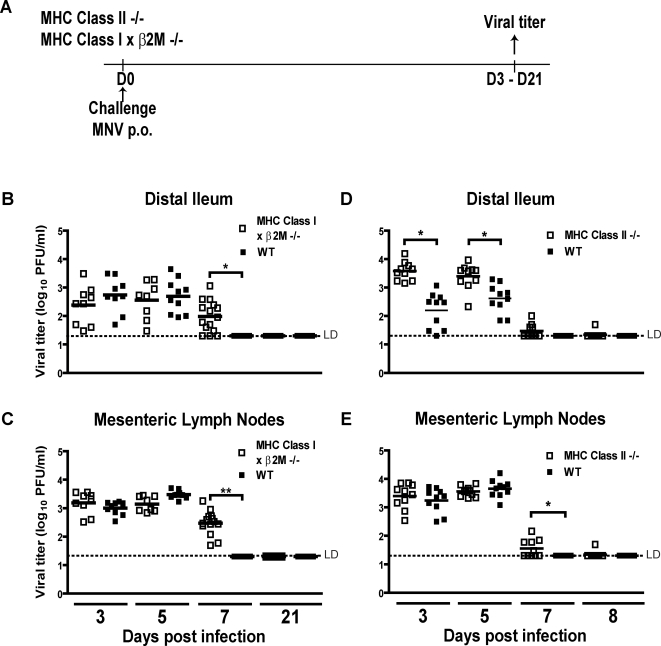
MHC Class II limits early MNV replication, and deficiency in MHC Class II or MHC Class I & β2M delays MNV clearance.(A) Protocol of challenge used in experiments in this figure. Viral titers in distal ileum (B,D) and MLN (C,E) of WT and MHC Class I×β2M-/- mice (B,C) and MHC Class II-/- mice (D,E) after infection with MNV1.CW3. These data are pooled from two to three independent experiments with 3–5 mice per group in each experiment. (**) indicates p<0.0001, (*) indicates p<0.05. LD indicates the limit of detection.